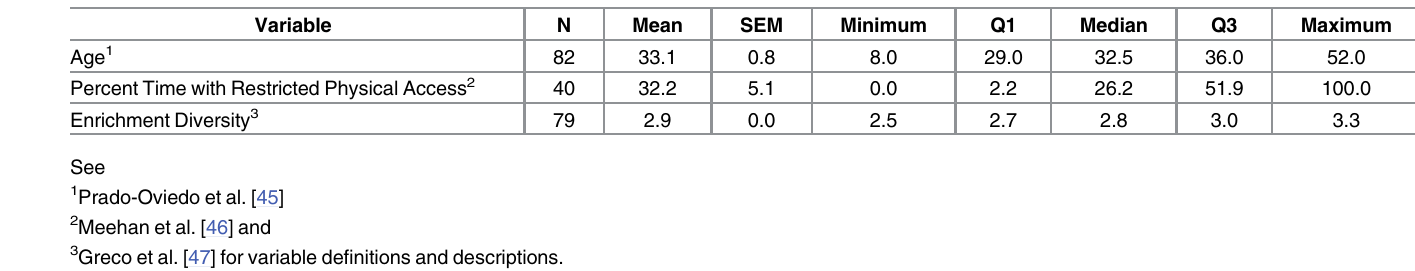
Table 7. Descriptive statistics for variables that were found to be significant in the cyclicity analyses for African elephants.